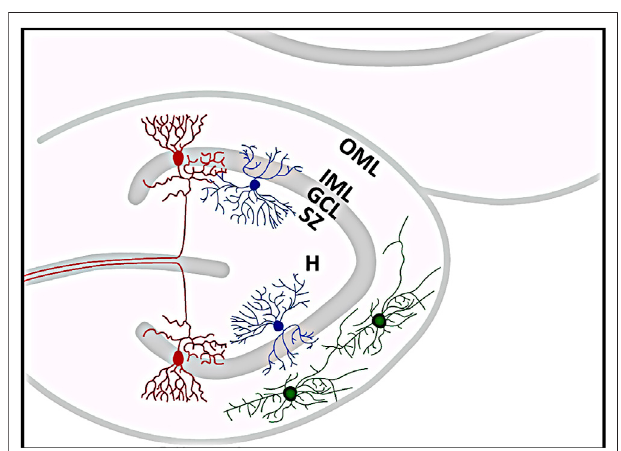
FIGURE 3 | Histological organization of the dentate gyrus (DG). Red neurons represent granule cells whose somata form the granule cell layer (GCL). Just below is the subgranular zone (SZ), where reelin-expressing interneurons(blue)canbefound,andaboveisthemolecularlayer,which can be further subdivided into an inner (IML) and an outer molecular layer (OML). The outer OML harbors reelin-synthesizing Cajal-Retzius cells (green). Thehilararea(H)oftheDGislocatedbelowtheSZ.Thetemplateforthis fi gure was (Marín-Padilla, 1998; Twible et al.,